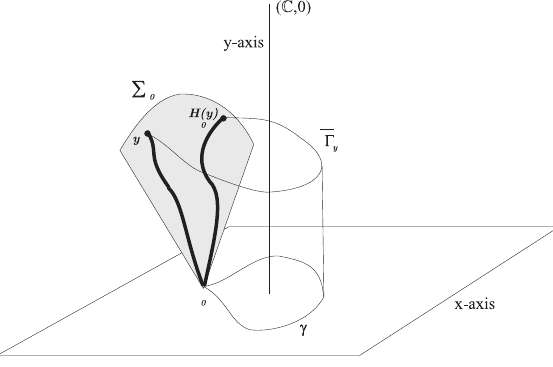
Figure 3 - The liftings of γ along the leaves of F X starting at points of L